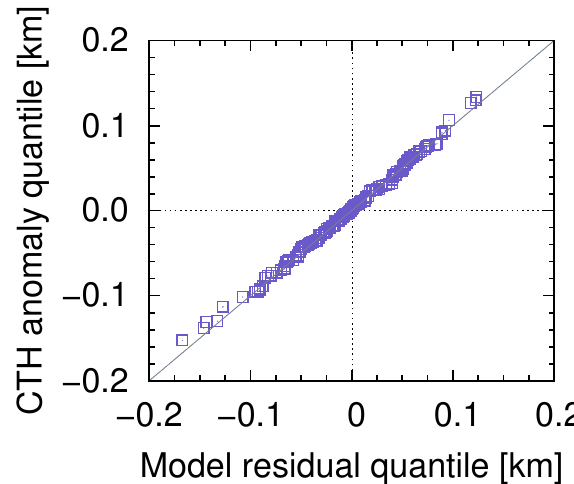
Figure 6. Normal quantile–quantile plot for global CTH anomalies vs. the theoretical residual quantiles estimated after regression with Eq. (3) and application of the parameter estimates ˆ α and ˆ β .